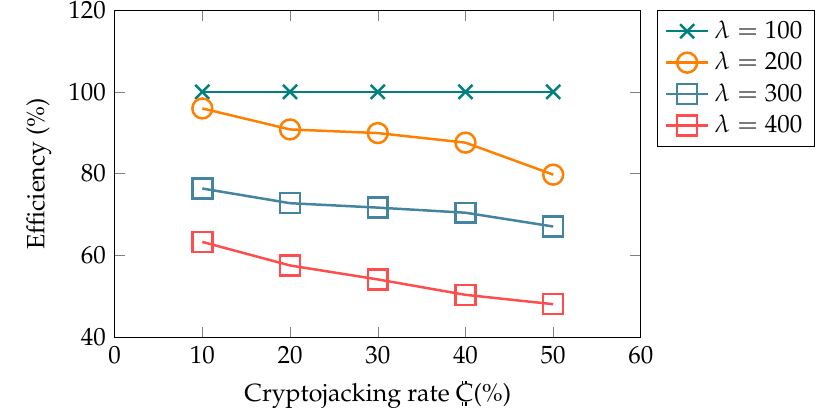
Figure 4. Showing the impact on system efficiency with varying cryptojacking